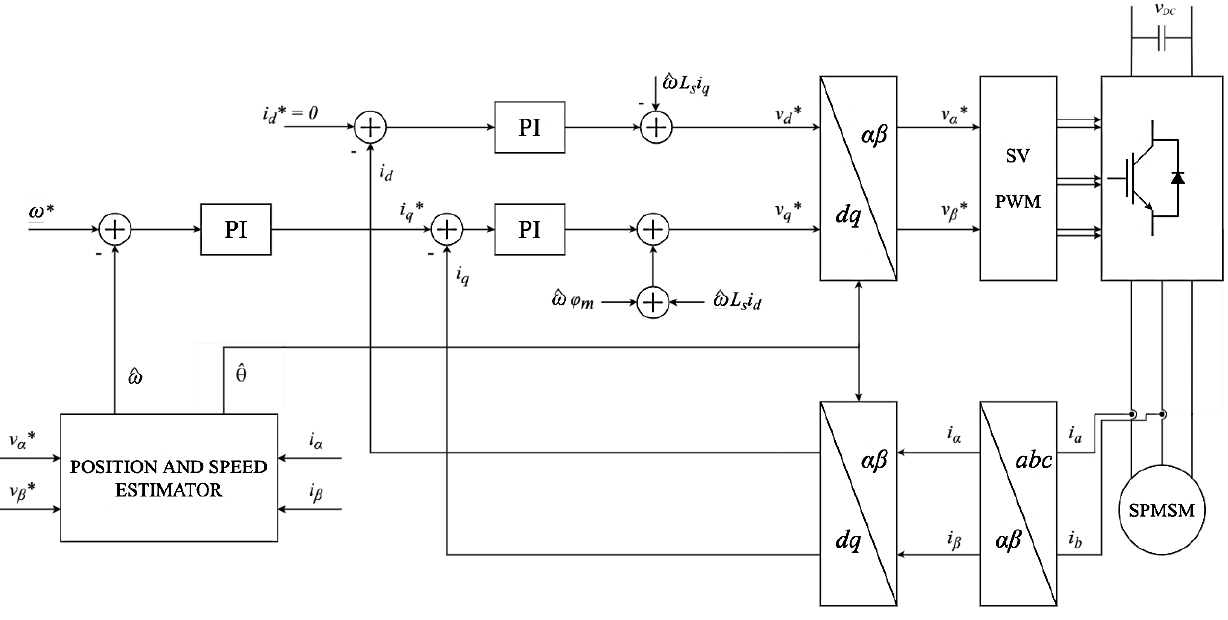
Figure 3. Sensorless FOC control scheme for PMSM.